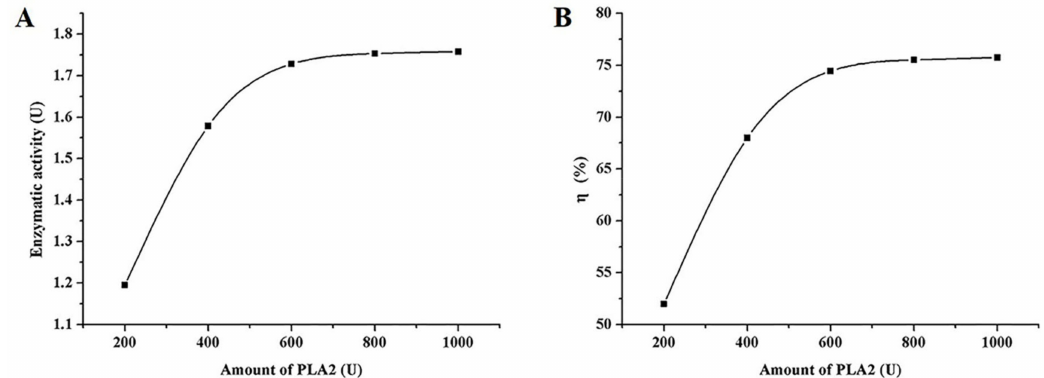
Figure 3. Influence of amounts of PLA 2 on ( A ) enzymatic activity and ( B ) the binding efficiency of immobilized